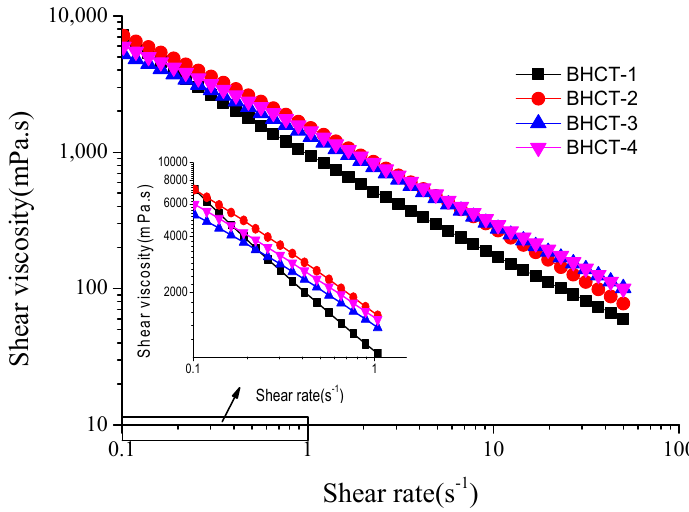
Figure 8. Viscosity curve of composite gel with different crosslinker concentrations.